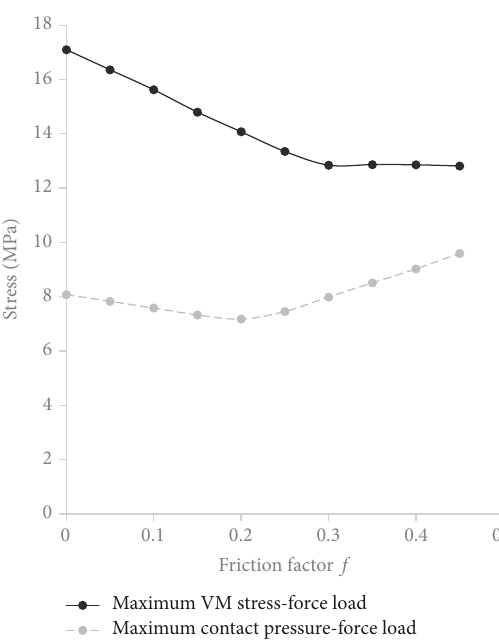
Figure 12: Maximum Von Mises stress and maximum contact pressure for different friction factors at a constant lead angle ( 𝛽 = 45 deg) under axial force load calculated by means of FEM